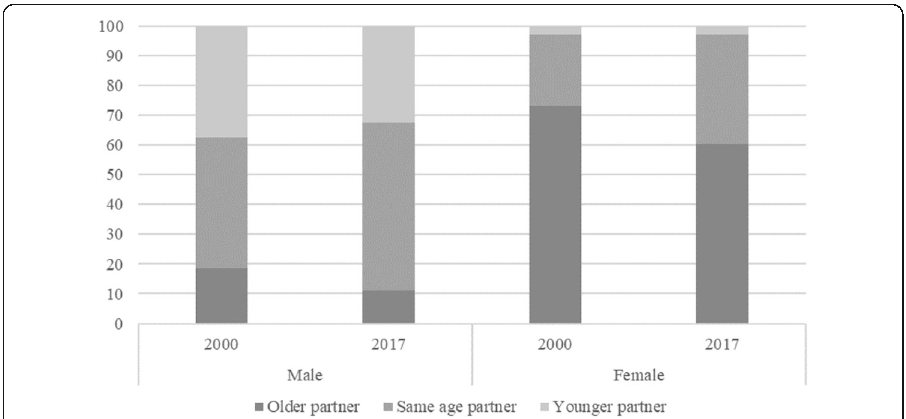
Fig. 1 Percentage distribution of type of discordant relationships at first sex by gender. Source: Own elaborations on SELFY 2000 and 2017